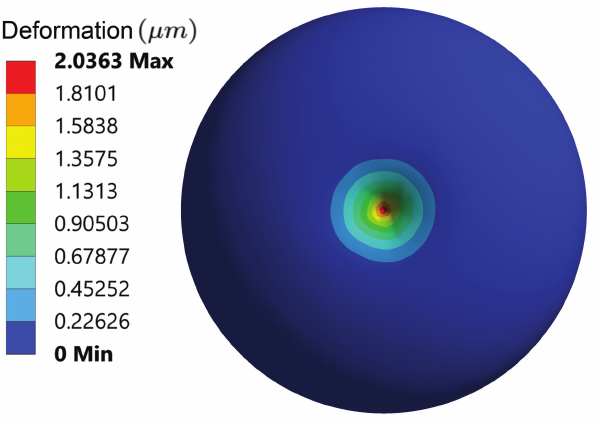
Figure 6. The total deformation of the hyperelastic components from the top view when indentation distance reaches 2µm.